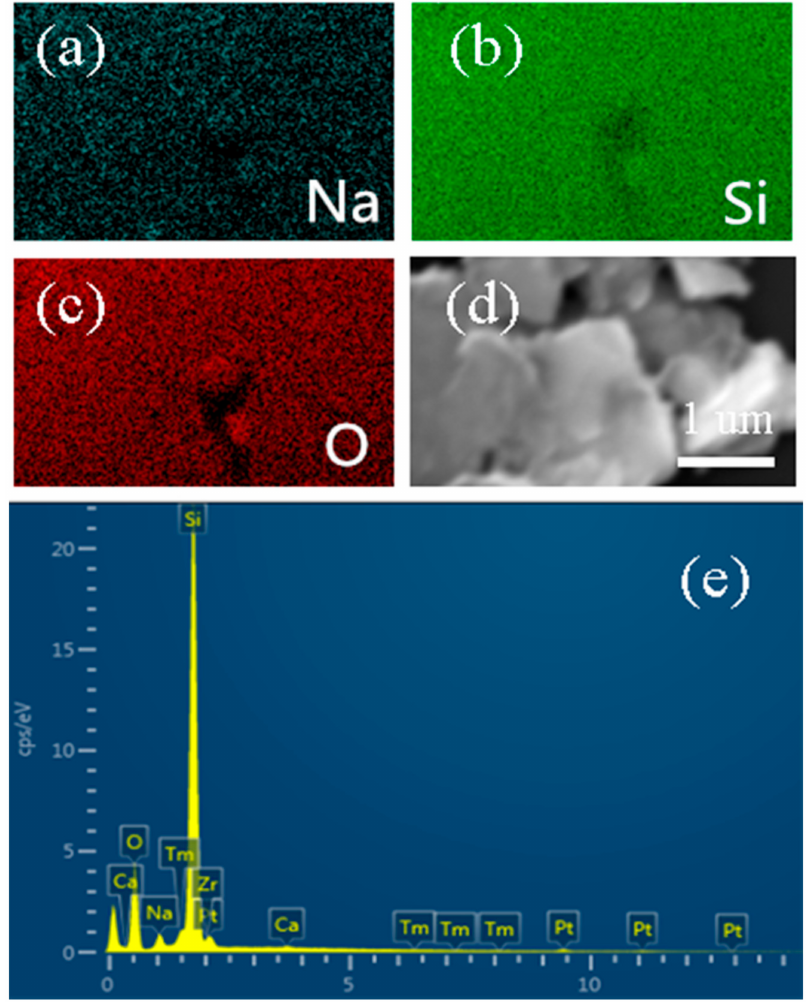
Figure 1. ( a – c ) the corresponding elemental mapping images of Na, O, Si from the selected of the sand core plate and ( d , e ) the (Energy Dispersive X-Ray Spectroscopy) EDS and SEM images of the sand core